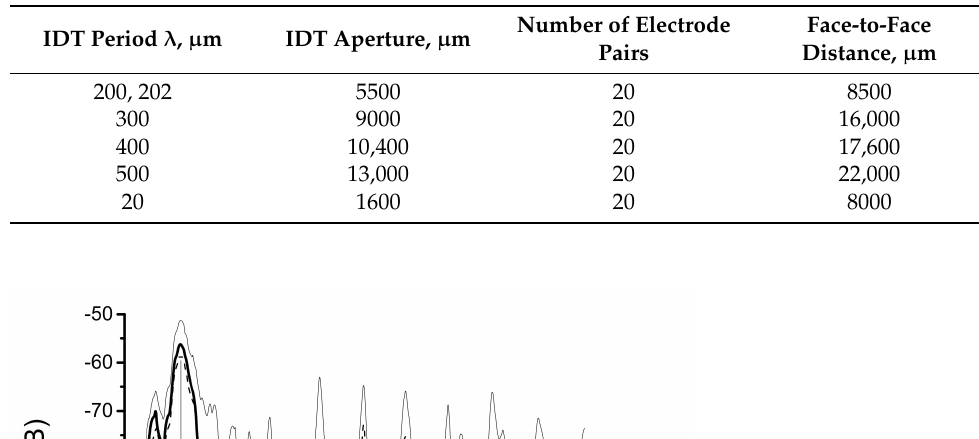
Figure 2. Schematic view ( a ) and photo ( b ) of a test sample with interdigital transducers generating Lamb and SH (PAW), and surface (SAW) acoustic waves. Table 2. The characteristics of the test samples.